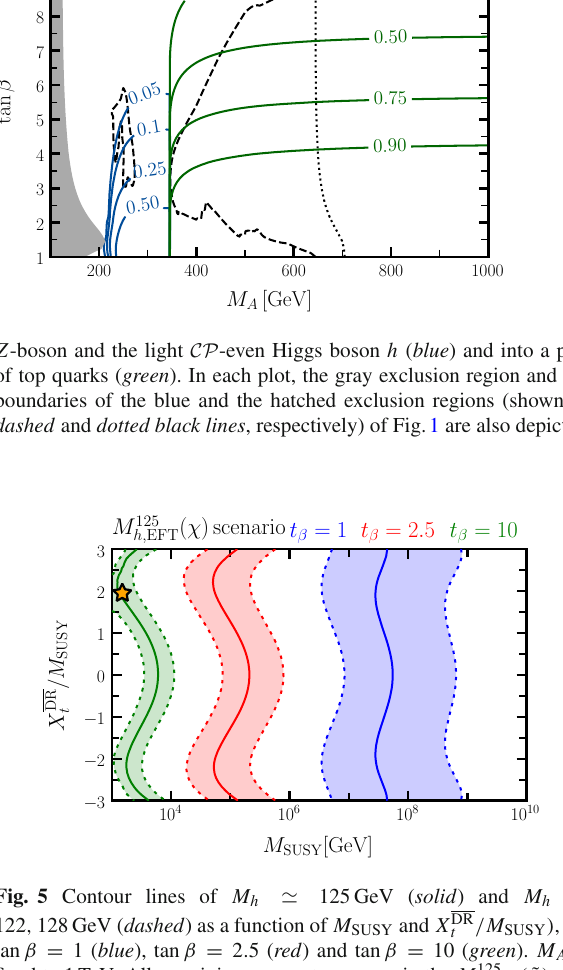
( ˜ χ) sce- h , EFT ( ˜ χ) h